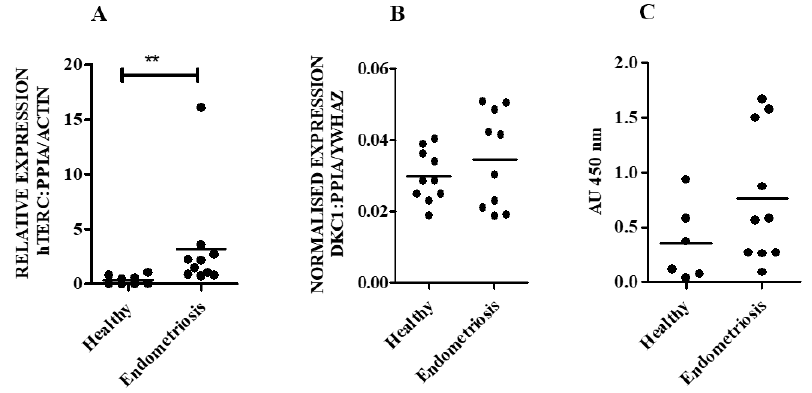
Figure 6. Eutopic secretory phase (SP) endometrium from women with confirmed endometriosis compared with SP from healthy women. ( A ) Human hTERC RNA in healthy secretory phase (SP) ( n = 8) and secretory phase from women with endometriosis ( n = 10). The hTERC RNA was normalised to the geometric mean of peptidylprolyl Isomerase A (PPIA) and beta actin (ACTB) reference genes. ( B ) DKC1 mRNA in healthy SP ( n = 10) and eutopic SP from women with endometriosis (n=10). The DKC1 mRNA was normalised to the geometric mean of PPIA and tyrosine 3-monooxygenase/tryptophan 5-monooxygenase activation protein zeta (YWHAZ) reference genes. ( C ) Telomerase activity (TA) in healthy SP ( n = 6) and in SP from women with endometriosis ( n = 10). ** p < 0.01.